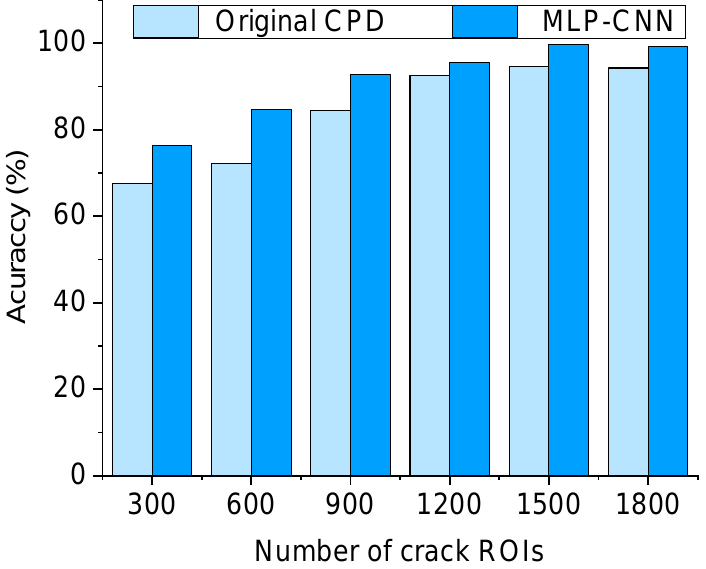
Figure 18. Accuracy of the original CPD and the MLP–CNN subject to different numbers of crack ROIs in the training set.